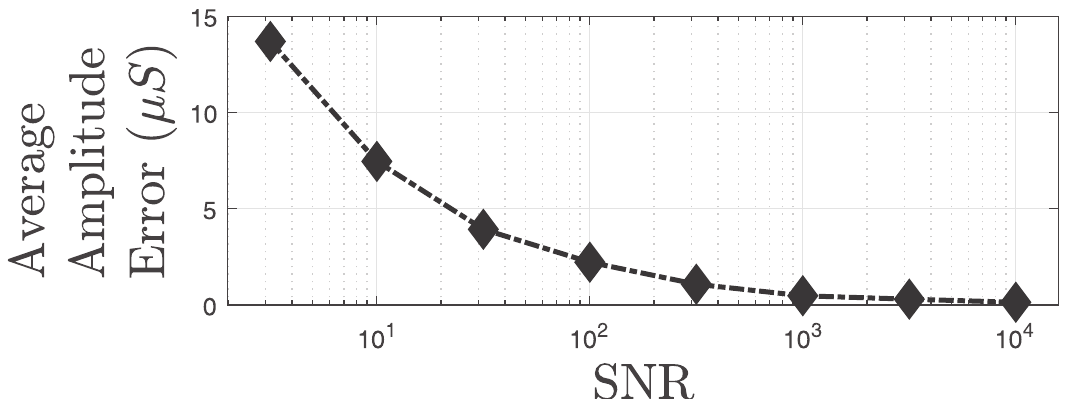
Fig 8. Average amplitude error of estimated ANS activation in different noise levels. Black diamonds with the dashed lines denotes the average amplitude error of the neural stimuli from estimated data with different noise levels. We have defined the average amplitude error as jk ~ u k (cid:0) k u k j = k u k , where ~ u and u represent the estimated and the ground truth neural stimuli, 1 1 0 respectively. The data is simulated using the obtained results from the all experimental data in [31]. The SNR is given with respect to the phasic component.